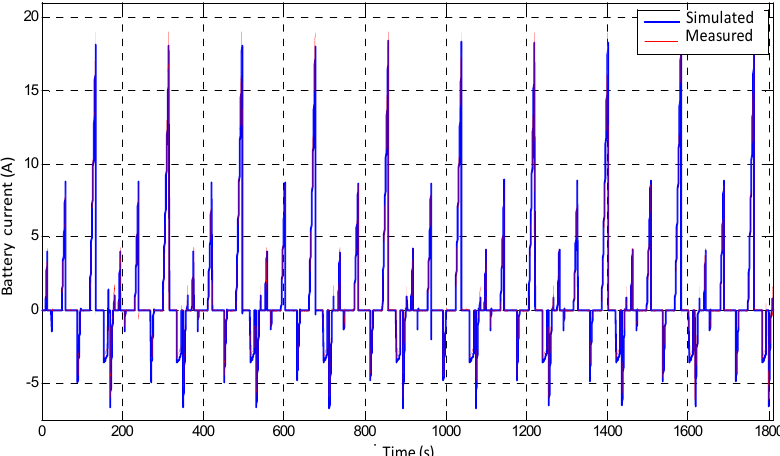
Figure 33. A detail of the first 10 driving cycles of both the measured and simulated battery current, along an 8 h working day.